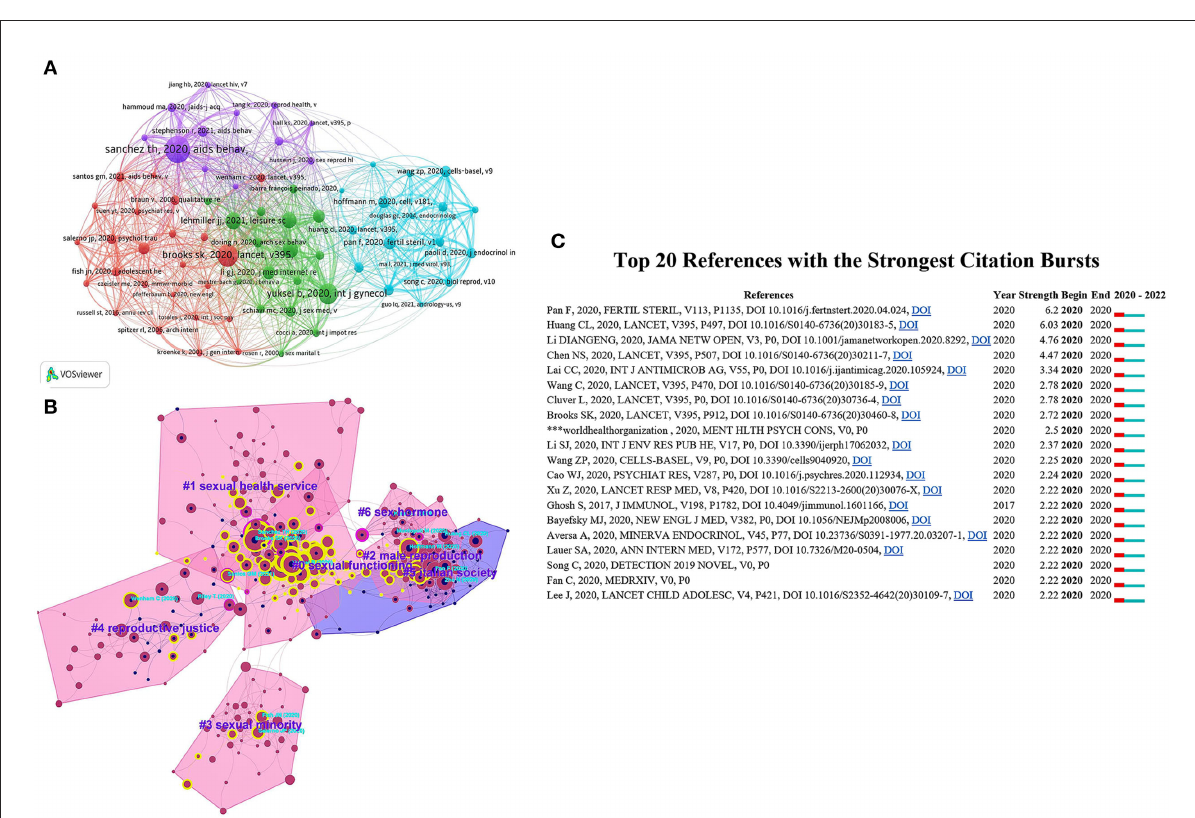
FIGURE6 Network visualization map of cited references. (A) Co-citation network of references. (B) Cluster analysis of references. (C) Top 20 references with the strongest citation bursts. ***,